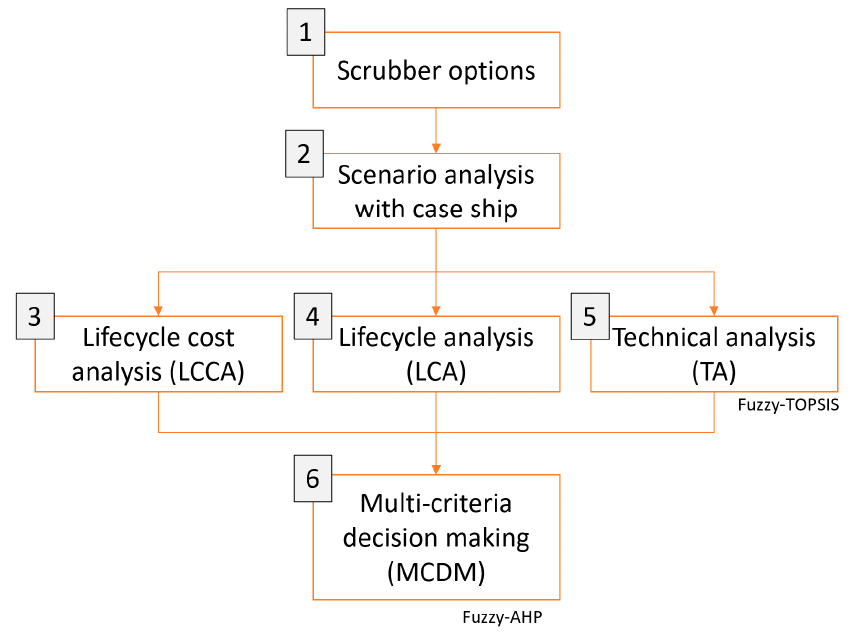
Figure 1. Research outlines.